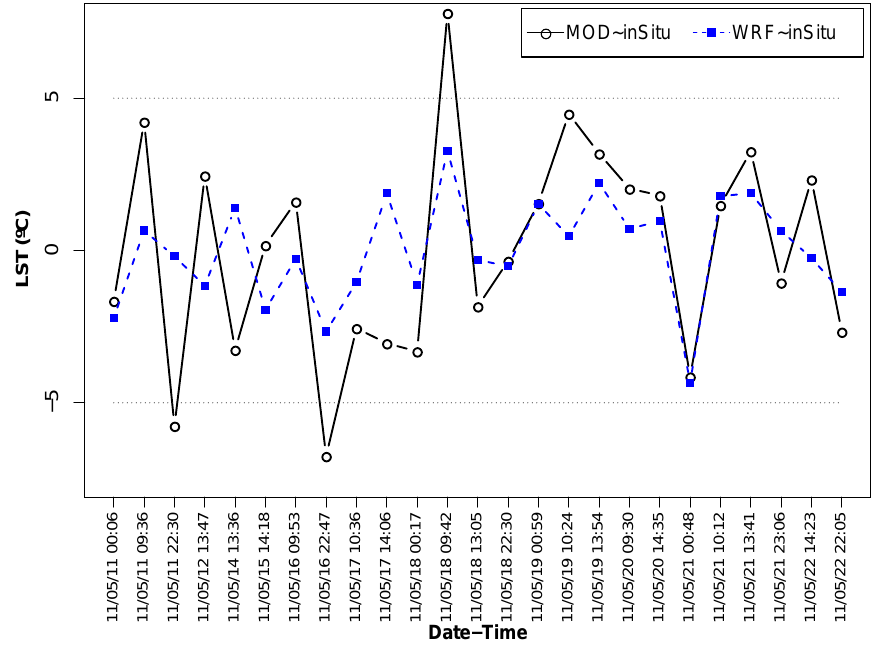
Figure 9. Regression residuals’ plot revealing the outliers in the MODIS LST dataset (controls are roughly equal to ± 1 . 5 σ , where σ = 3 . 57 is the residual standard error of regression when the MODIS LST time-series is correlated with the in situ